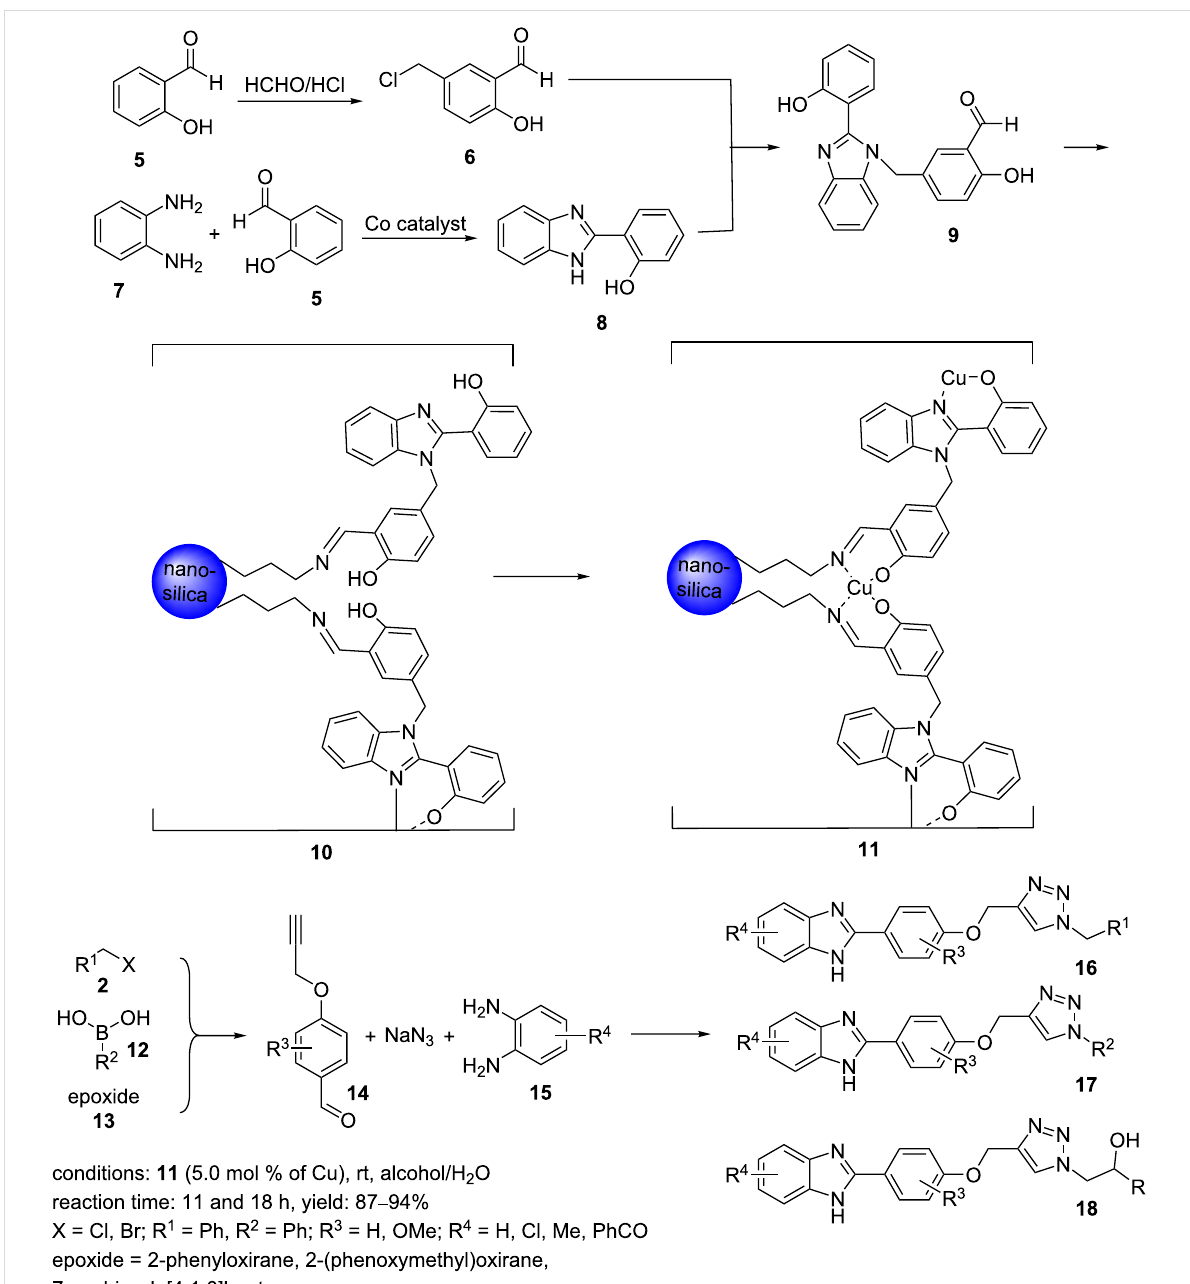
Scheme 2: Synthetic route to the catalyst 11 and its catalytic application in CuAAC reactions.